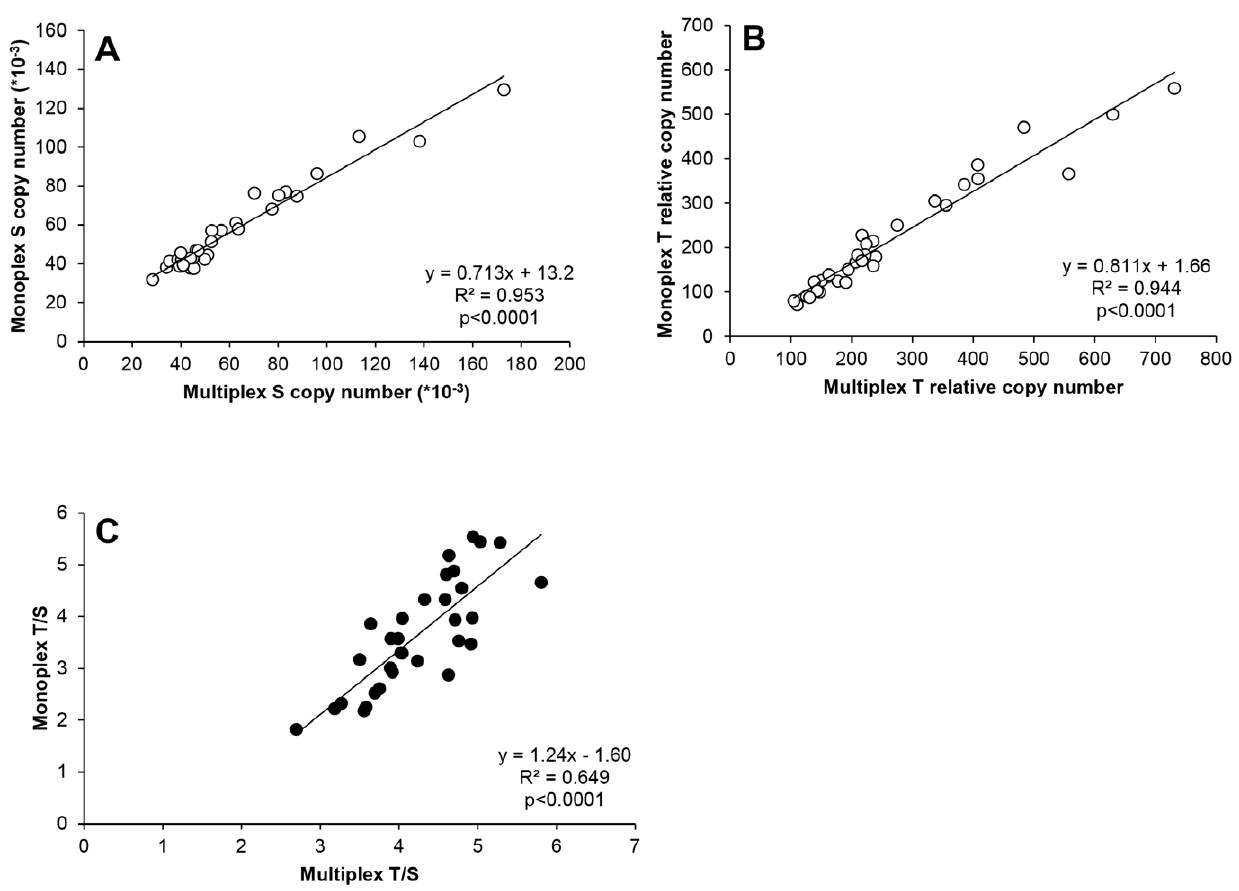
Figure 3. Correlation between monoplex and multiplex qPCR. ACD WB (N=32) samples were measured by monoplex and multiplex qPCR. Correlations were done between S (panel A), T (panel B) and T/S (panel C). Pearson’s R 2 and p values are shown.